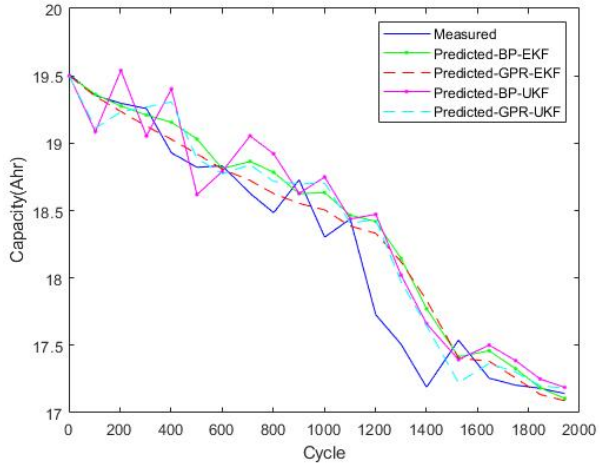
Figure 5. Prediction for battery based on capacity test cycles.